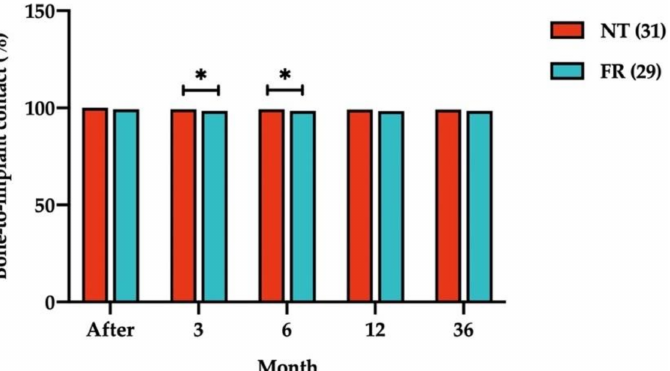
Figure 6. Comparison of percentage of bone-to-implant contact between natural teeth (NT) and fixed restorations (FRs) in the opposing arch at all follow-up times. Numbers in parentheses indicate the numbers of NT and FRs. Measurements at the bottom of the graph refer to the time of implant loading. * p <